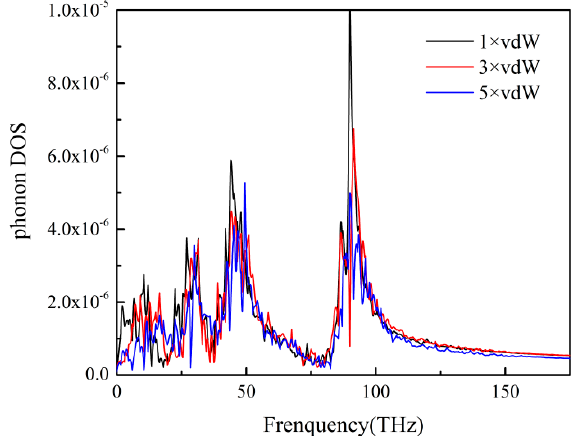
Figure 12. The phonon DOS of PP atoms with different interface interactions.